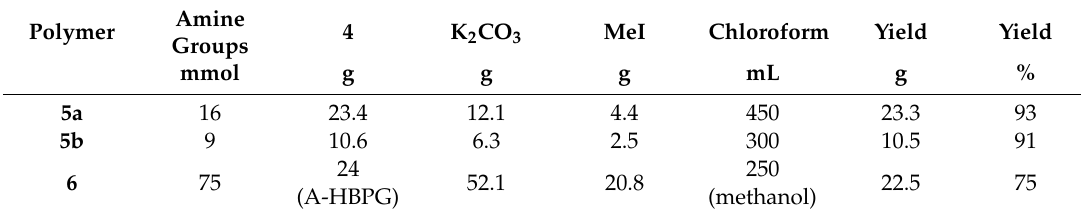
Table 5. Amounts of reagents used for the reaction of quaternization of 4 and A-HBPG and the reaction